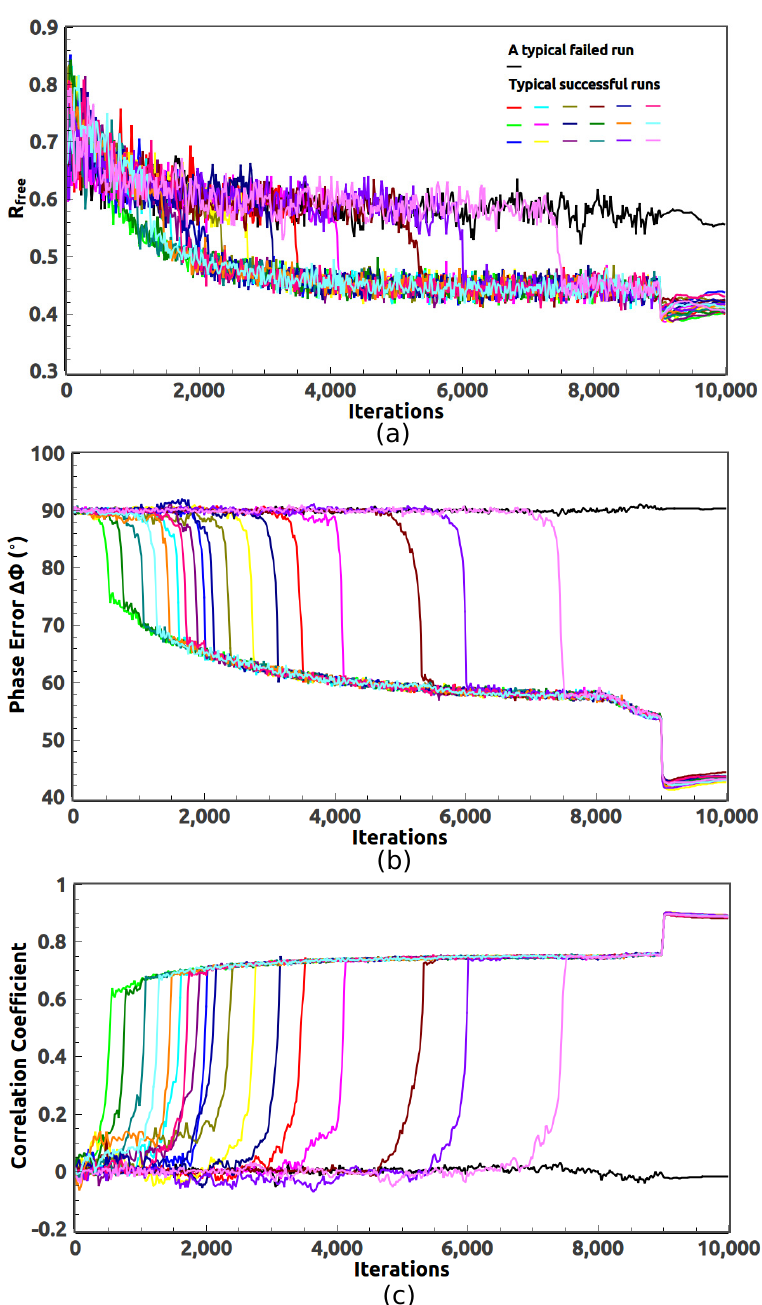
Figure 13. Evolution of the error metrics of 5AP9 starting from random phases. ( a ) Free R-value, ( b ) mean phase error, and ( c ) correlation